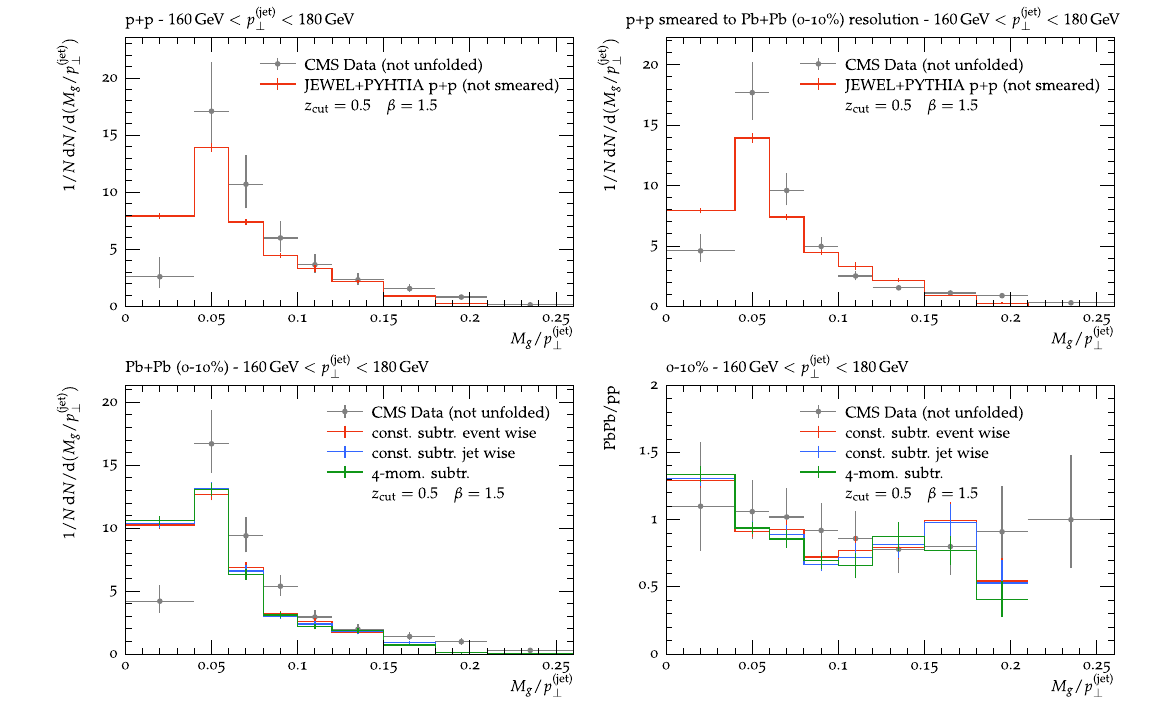
( jet ) < 180 GeV. CMS data [78] and JEWEL+PYTHIA 160 GeV < p ⊥ results with different subtraction methods. The CMS measurement has not been unfolded and the JEWEL+PYTHIA results have not been smeared, so a direct comparison is not